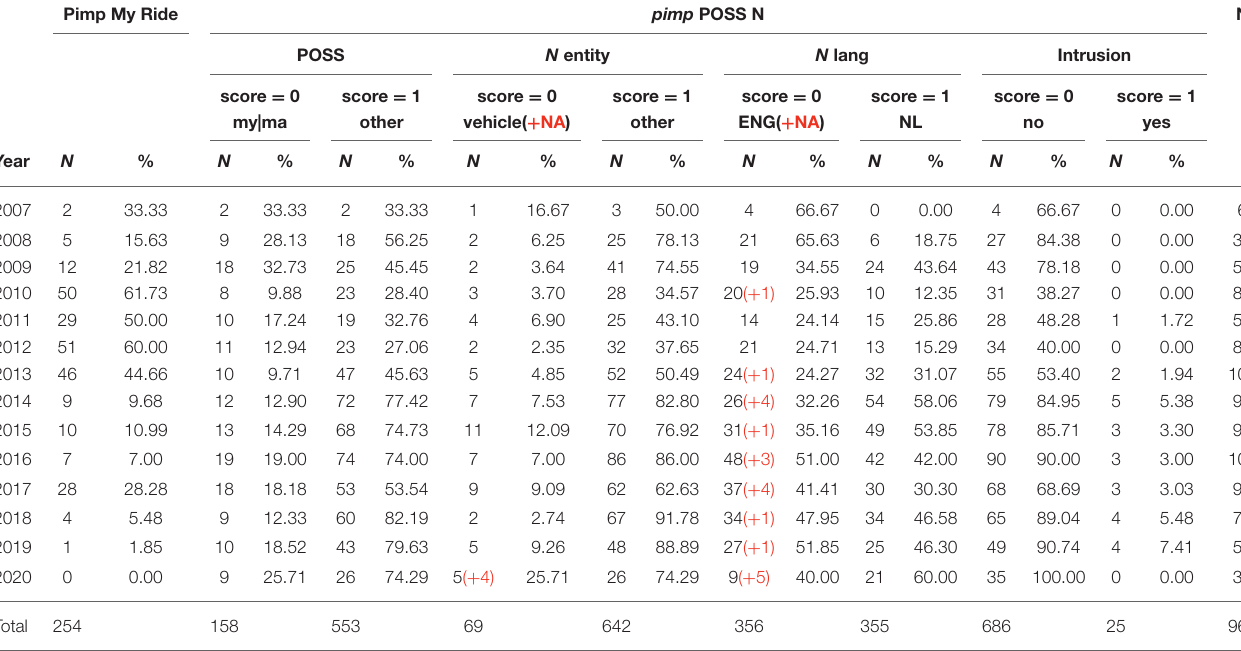
TABLE 3 | Tokens per category for observations outside of the target construction (NA’s marked in red). Verbal